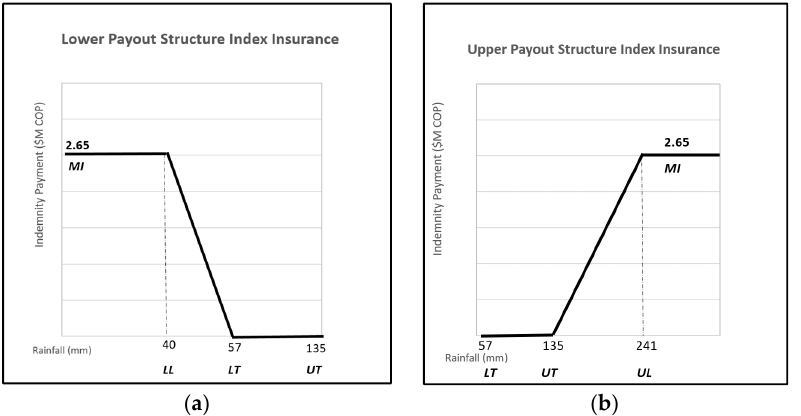
Figure 5. Indemnity structure for the lower and upper average PTPM. ( a ) Lower precipitation ranges, ( b ) upper precipitation ranges. Notes: (1) Low and high rainfall index insurance are annually seasonalized. (2) Lower limit (LL); upper limit (UL); lower threshold (LT); upper threshold (UT); and max indemnity (MI) [17]. Source: adjusted according to Abrego-P et al. [18].